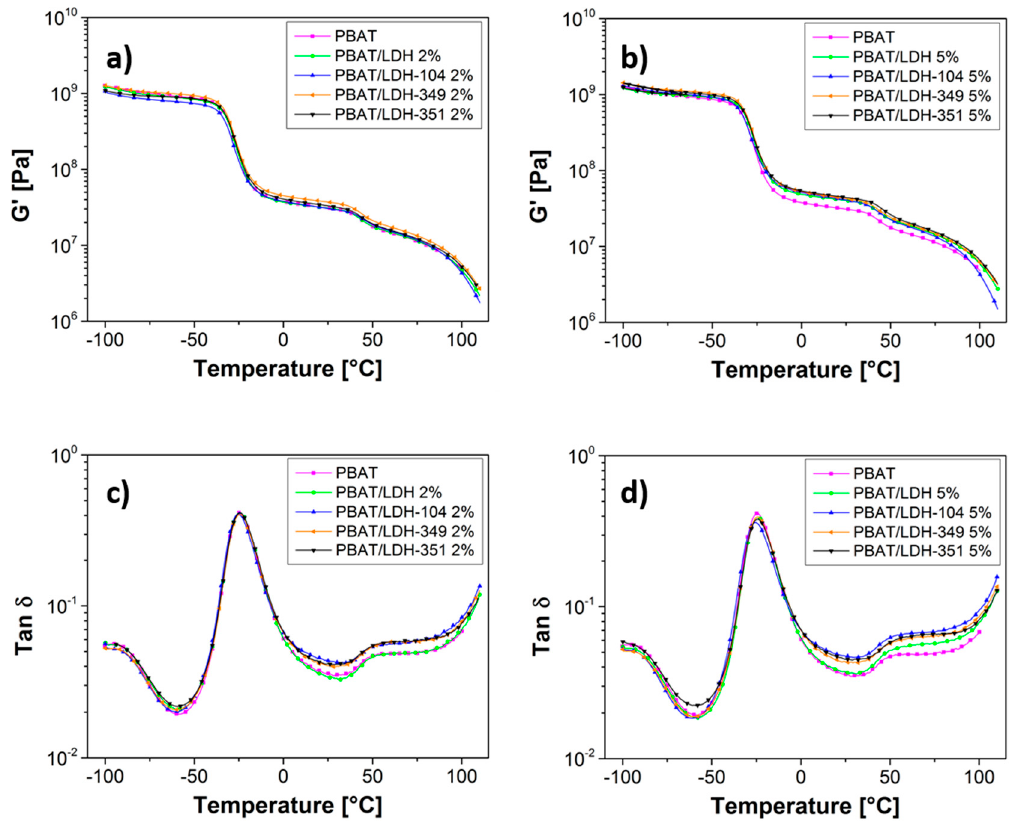
Figure 6. Storage moduli G’ ( a , b ), main relaxation peak of PBAT and the resulting nanocomposites evidenced on tan δ diagrams ( c , d ) recorded at 1 Hz.